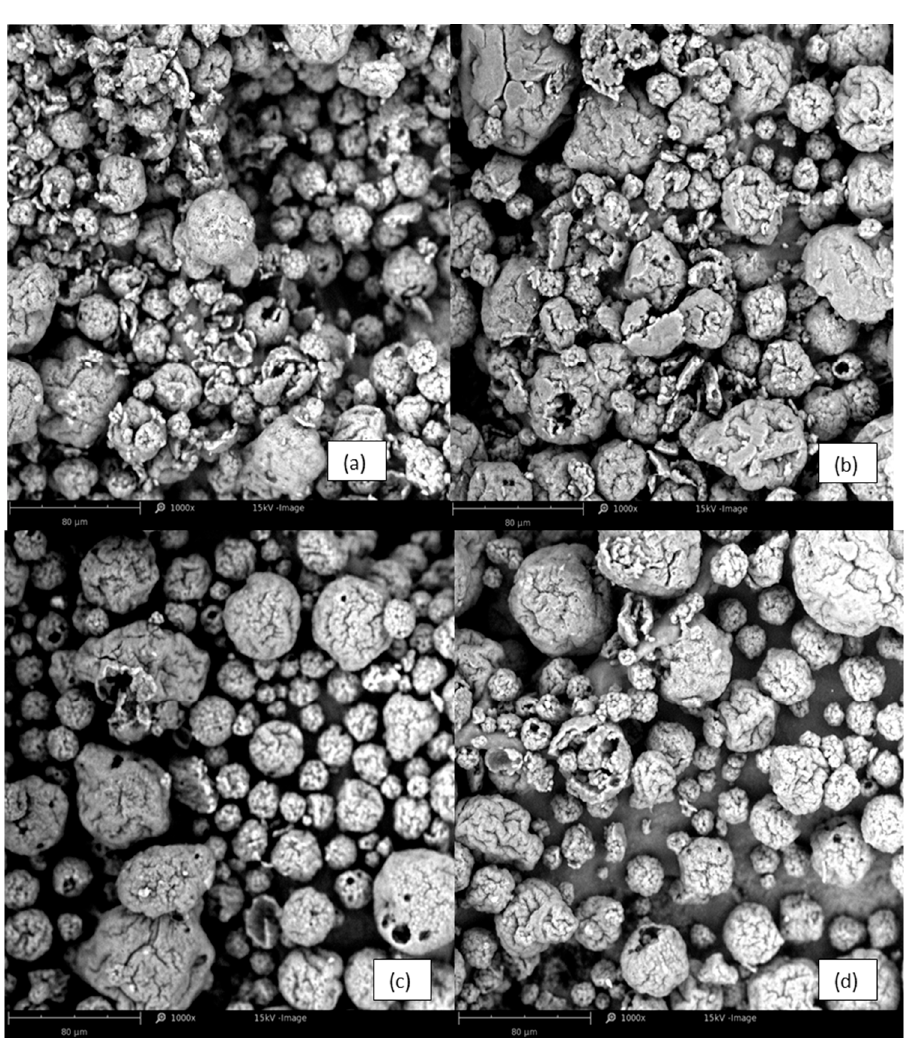
Figure A4. SEM image of dried Chlorella sp. after Soxhlet extraction by mixture of C:H:M at ratio of ( a ) 1:1:1; ( b ) 2:1:3; ( c ) 3:2:1, and ( d ) 1:2:3 at 1000× magnification 15 kV.